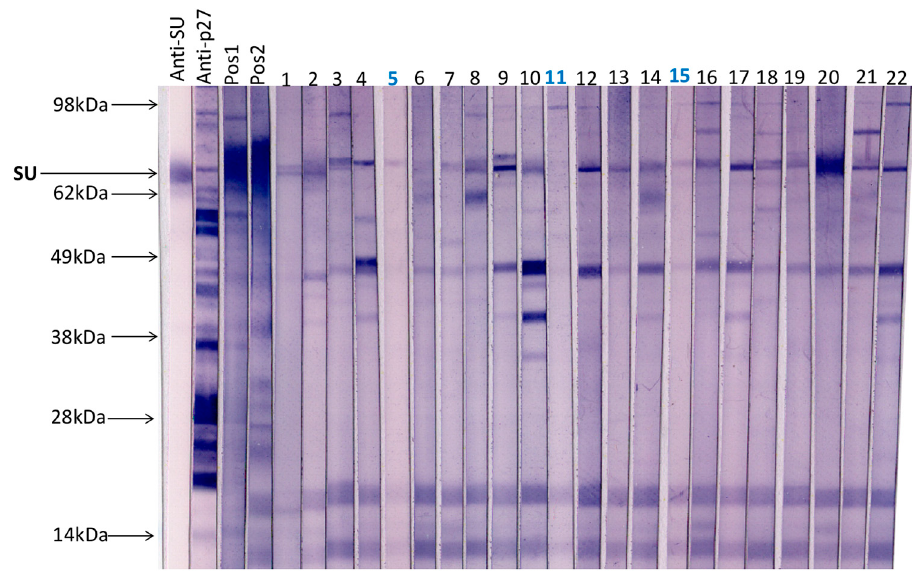
Figure 3. A total of 20 field cat plasma samples (samples 1–20) and two plasma samples from FeLV naïve specific pathogen free cats (samples 21 & 22) were tested by immunoblotting to determine antibody reactivity to FeLV-A proteins. Each strip was probed individually with a cat plasma or antibody control. Anti-SU (surface unit, gp70) and anti-p27 antibodies were used as controls as well as a pooled positive plasma sample with a VNA titre ≥ 1:128 (Pos1) and a cat plasma with a high VNA titre (VNA titre ≥ 1:32, Pos2). Three samples with the least reactivity to FeLV-A virus (highlighted in blue, samples 5, 11 and 15) were selected, pooled and used subsequently as a negative control.